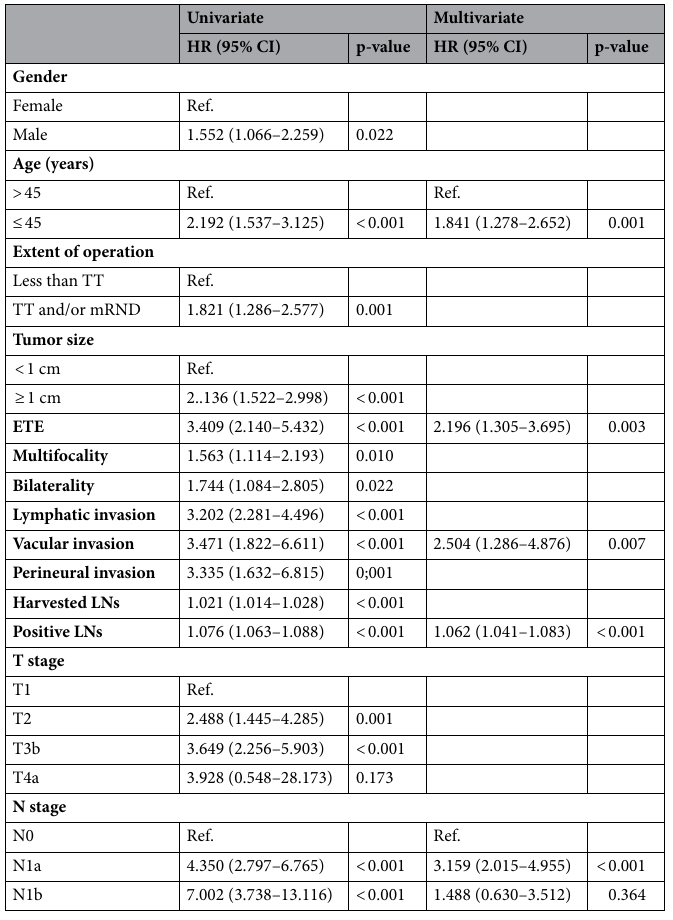
Propensity score matching yielded 1040 matched pairs of patients. There were no significant differences in clinicopathological characteristics, including the recurrence rate, between the matched groups (Table 1).